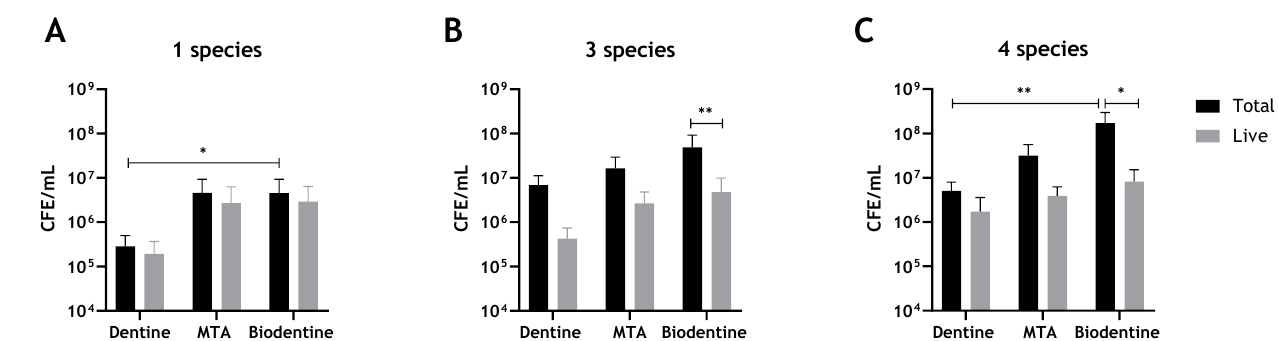
Figure 1. Compositional analysis of biofilms on MTA, Biodentine and bovine dentine discs. Biofilms were grown and assessed using live/dead qPCR. ( A ) Total and live CFE/mL of C. albicans -only biofilms, ( B ) Total and live CFE/mL of 3-species bacterial-only biofilms ( S. gordonii , P. gingivalis and F. nucleatum ). ( C ) Total and live CFE/mL of 4-mixed biofilms (bacteria and C. albicans ). Data were analysed by Kruskal–Wallis with Dunn’s tests to determine the p values for non- parametric multiple comparisons. Differences were considered statistically significant when p < 0.05. * Indicates statistically significant differences (* p < 0.05, ** p < 0.01). Data representative of biofilms from three independent repeats n = 3 with 3 technical replicates.